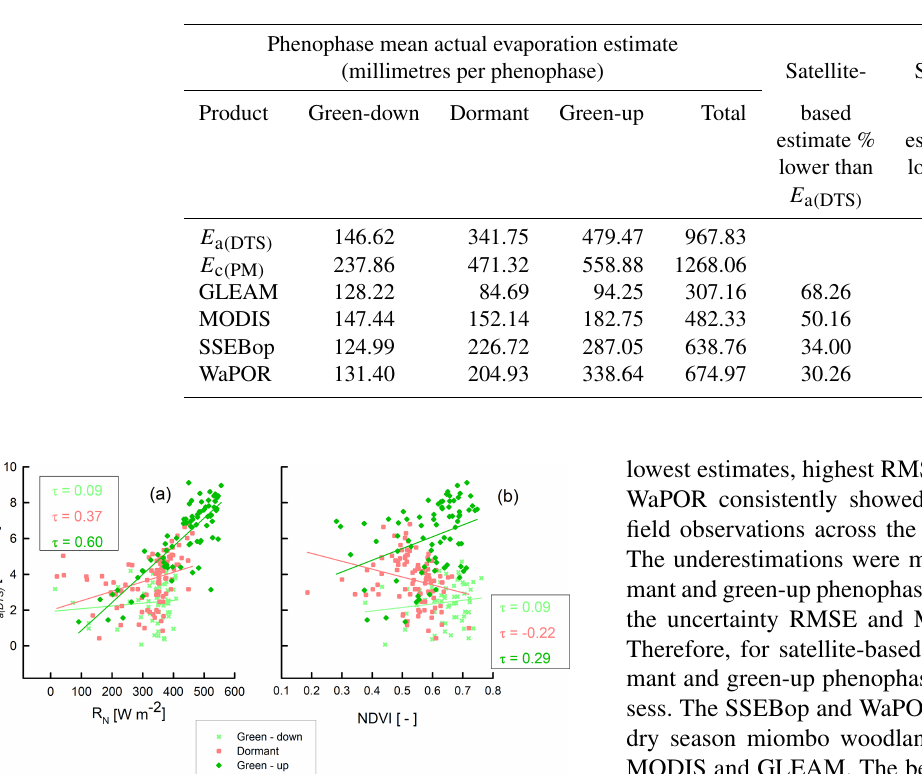
Table 2. Comparison of the 2021 monthly cumulative evaporation at Mpika miombo woodland site.